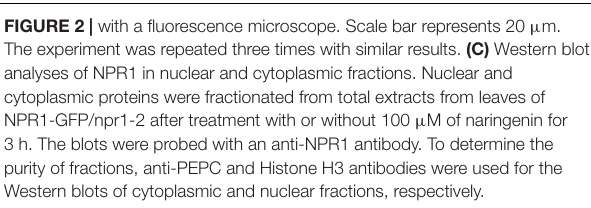
FIGURE 2 | with a fluorescence microscope. Scale bar represents 20 µ m. The experiment was repeated three times with similar results. (C) Western blot analyses of NPR1 in nuclear and cytoplasmic fractions. Nuclear and cytoplasmic proteins were fractionated from total extracts from leaves of NPR1-GFP/npr1-2 after treatment with or without 100 µ M of naringenin for 3 h. The blots were probed with an anti-NPR1 antibody. To determine the purity of fractions, anti-PEPC and Histone H3 antibodies were used for the Western blots of cytoplasmic and nuclear fractions, respectively.